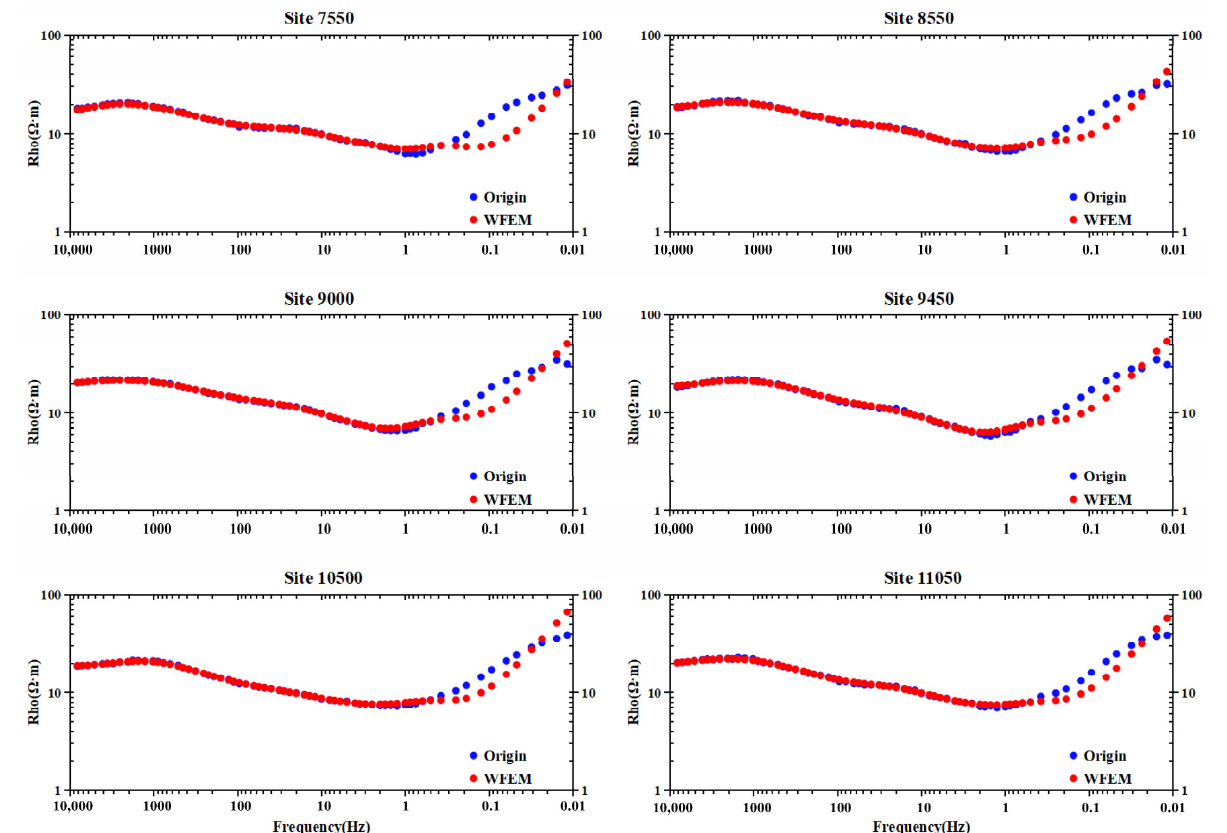
Figure 7. Apparent resistivity response curves of the WFEM inversion model.